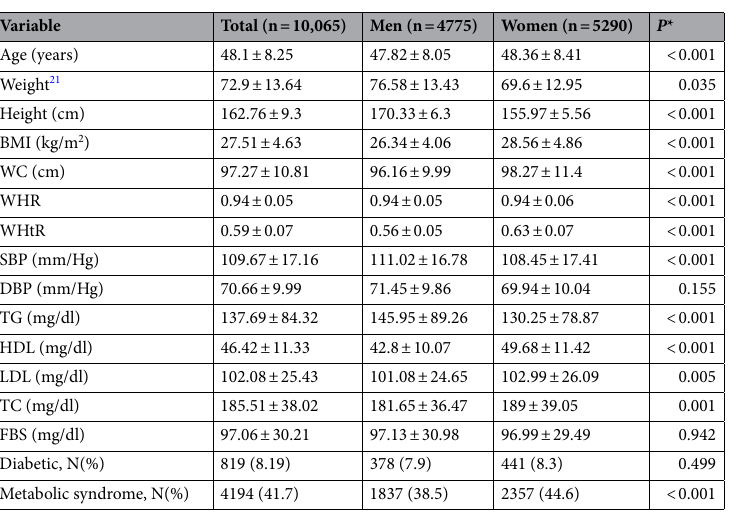
Table 1. General characteristics of the studied population. BMI body mass index, WC waist circumference, WHR waist to hip ratio, WHtR waist to height ratio, SBP systolic blood pressure, DBP diastolic blood pressure, TG triglyceride, HDL high density lipoprotein, LDL low density lipoprotein, TC Total cholesterol, FBS fasting blood sugar. * P value was obtained student T test and Chi